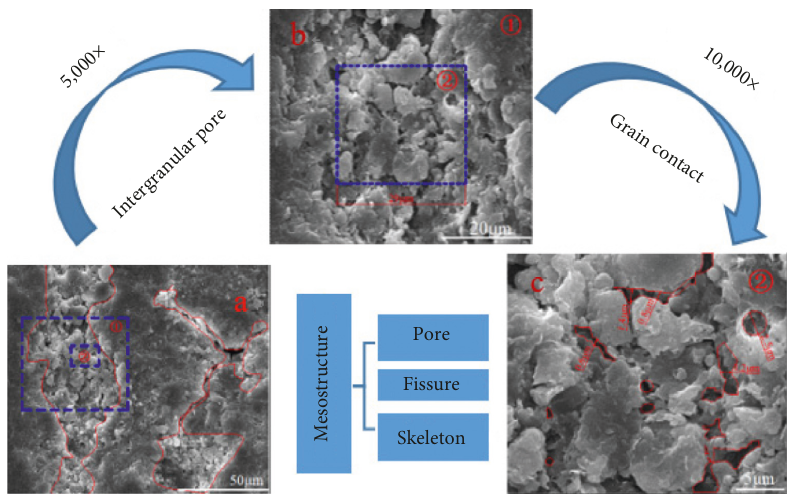
, (b) 5000 , and (c) 10,000 . × × ×